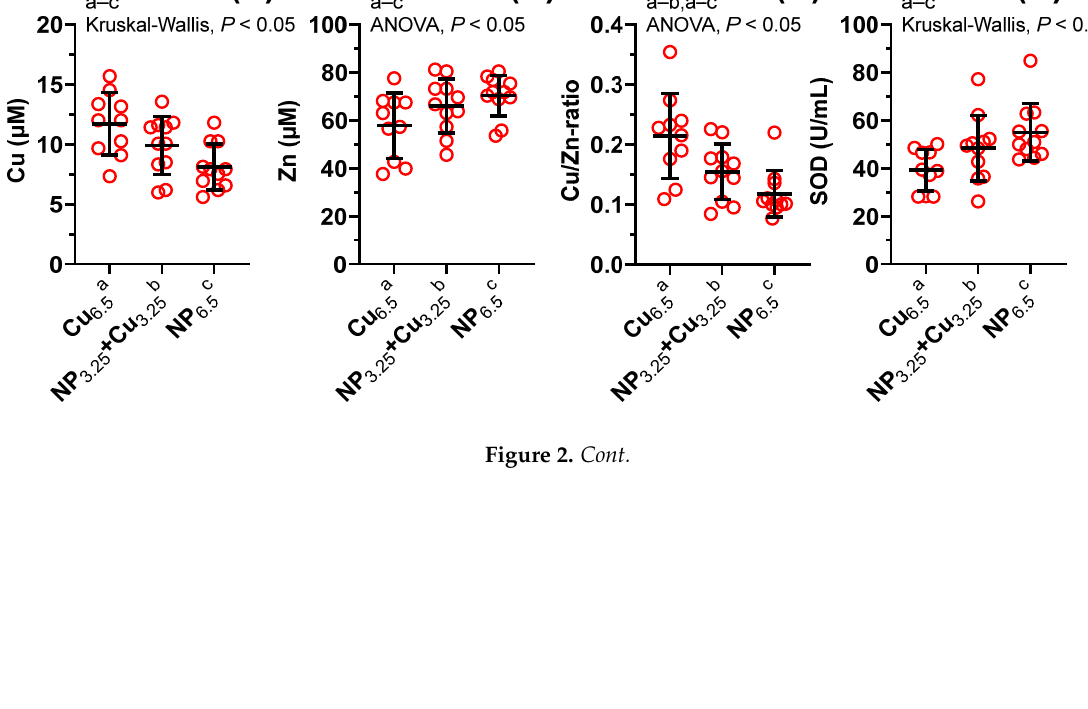
Figure 2. The influence of experimental diets on Cu, Zn content ( A – C ), and antioxidant mechanism ( D – H ) in blood plasma. Values are expressed as means ± SD of n = 11 rats. Supplementation with NP 6.5 decreased the Cu (×0.7), Cu/Zn-ratio (×0.6), catalase (CAT, ×0.7), and increased Zn (×1.2), and superoxide dismutase (SOD, ×1.4). NP 3.25 + Cu 3.25 decreased the Cu/Zn- ratio (×0.7), and CAT (×0.7). 3.3. Vascular Reactivity Studies Neither NP 3.25 + Cu 3.25 (AUC: ×0.85) nor NP 6.5 (AUC: ×1.18) changed the vasodilation compared to the control Cu 6.5 . However, there was a tendency to increased vasodilation at 10 nM of ACh in NP 6.5 (see Figure 3). Moreover, significant change was observed in NP 3.25 + Cu 3.25 compared to NP 6.5 (AUC: ×0.72). Preincubation with NS-398 diminished that response (between NP 3.25 + Cu 3.25 and NP 6.5 ), which was completely abolished with indo- methacin (see Table 1).